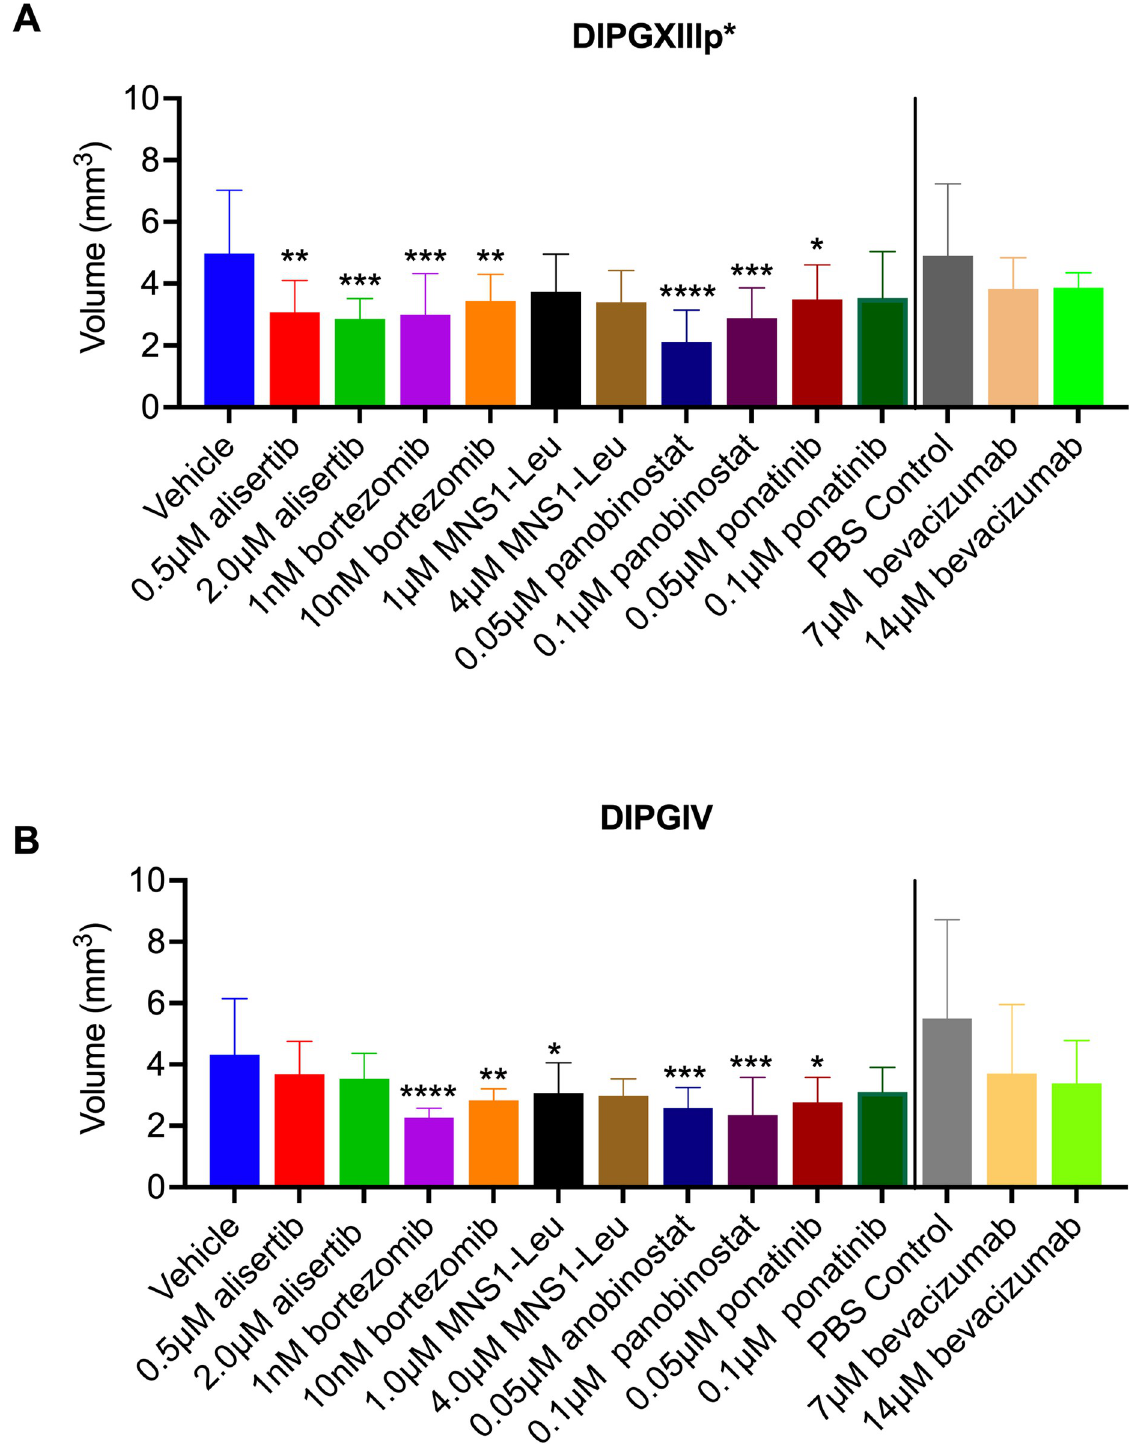
Fig 3. Volumetric analysis of DIPGXIIIp � and DIPGIV CAM tumors following drug treatment. DIPGXIIIp � (A) and DIPGIV (B) CAM tumors were treated with alisertib, bortezomib, MSN1-Leu, panobinostat, ponatinib and bevacizumab on embryonic development days 11, 13 and 15. Tumor volume was determined following 3-D ultrasound on embryonic development day 16. Vehicle is 0.5% DMSO in sterile PBS. PBS control is 100% sterile PBS. Differences were determined with one-way ANOVA and Dunnett’s test for multiple comparisons where P < 0.05 is considered significant. P < 0.05 = � , P < 0.01 = �� , P < 0.001 = ��� , P < 0.0001 = ���� .